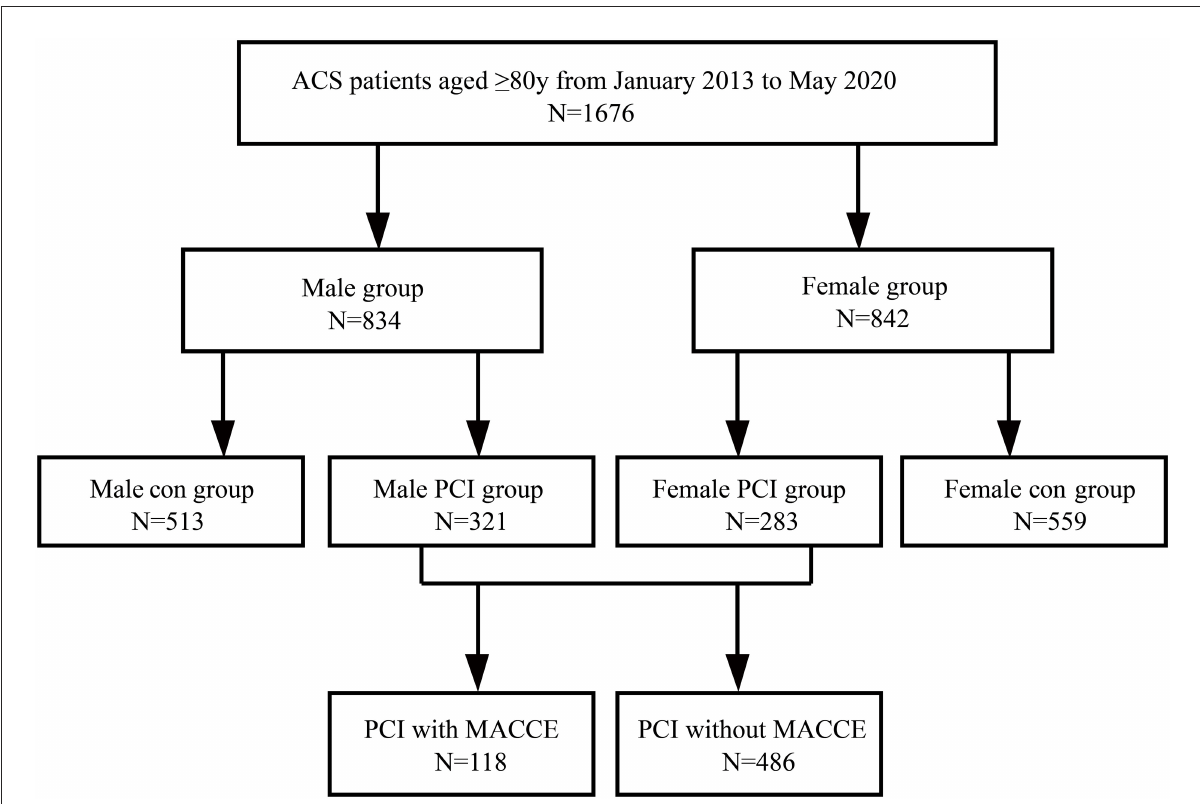
FIGURE1 Patients’ enrollment flow. ACS, acute coronary syndrome; PCI, percutaneous coronary intervention; MACCE, major adverse cardiovascular and cerebrovascular events; con, conservative